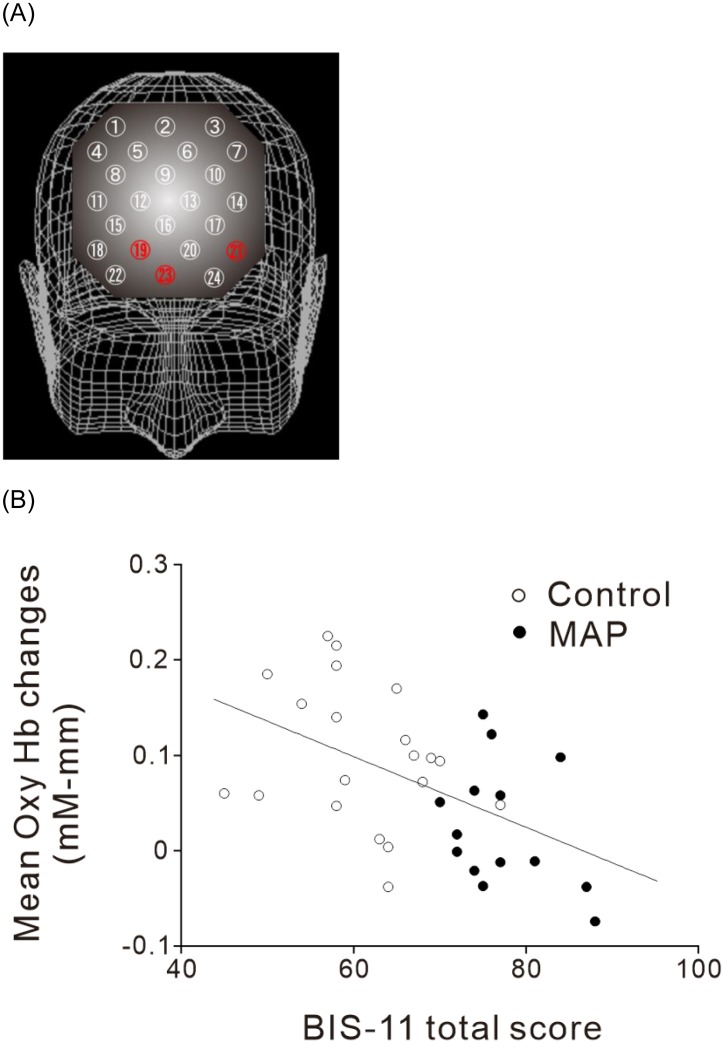
Correlation between total BIS-11 score and hemodynamic change in all participants.(A) Three-dimensional topographical mapping of the channels showing significant correlations between total BIS-11 score and hemodynamic response (Ch 19, 21, and 23, labeled in red). (B) A representative scatter plot showing significant correlation in Ch 19 (ρ = −0.537, p<0.01). The black and open circles represent the MAP group and controls, respectively. Abbreviations: Ch, channel; BIS-11, Barrett Impulsivity Scale-11; Hb, hemoglobin.